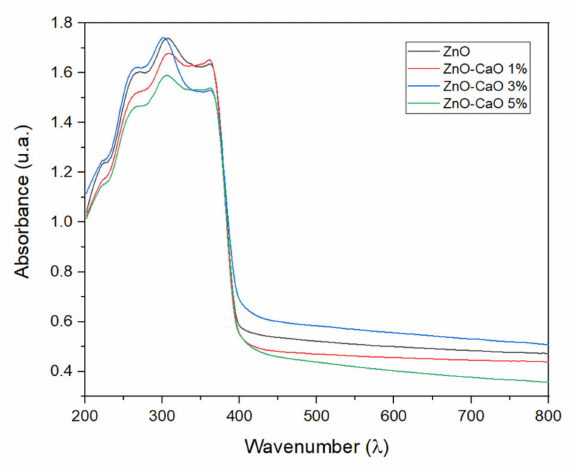
Figure 9. UV-Vis spectra and determination of the bandgap energies for ZnO, Zn-Ca 1, Zn-Ca 3, and Zn-Ca 5.